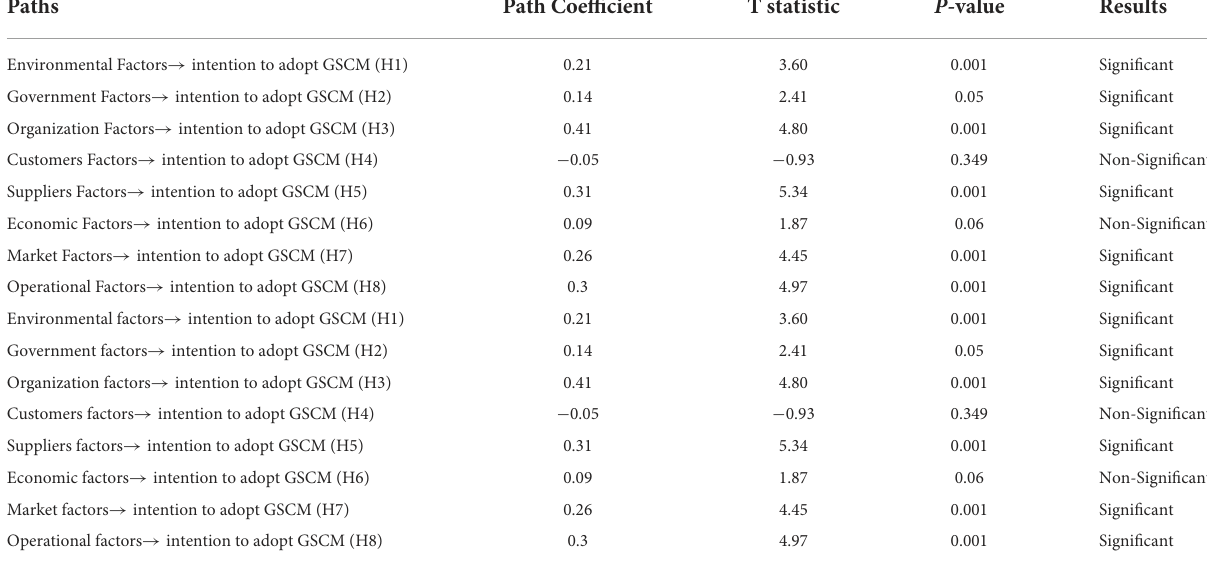
TABLE 8 Results of estimating the analysis of the structural